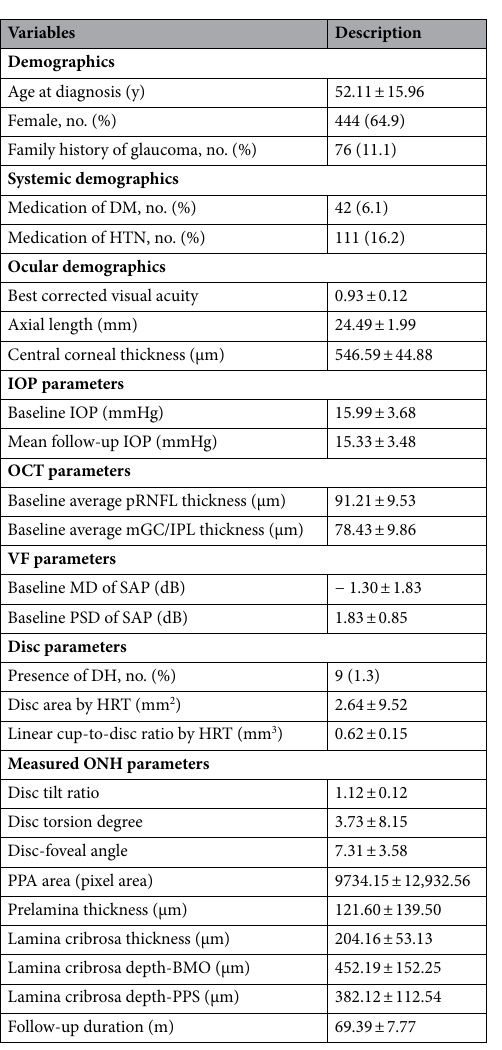
Table 1. Baseline demographics and ocular characteristics of 684 eyes of 379 NTG suspects. DM, diabetes mellitus; HTN, systemic hypertension; OCT, optical coherence tomography; pRNFL, peripapillary retinal nerve fiber layer; mGC-IPL, macular ganglion cell-inner plexiform layer; IOP, intraocular pressure; VF, visual field; MD, mean deviation; PSD, pattern standard deviation; dB, decibel; MD, mean deviation; SAP, standard automated perimetry; DH, disc hemorrhage; HRT, Heidelberg retinal tomograph; ONH, optic nerve head; PPA, peripapillary atrophy; BMO, Bruch’s membrane opening; PPS, peripapillary sclera. Data are mean ± standard deviation unless otherwise